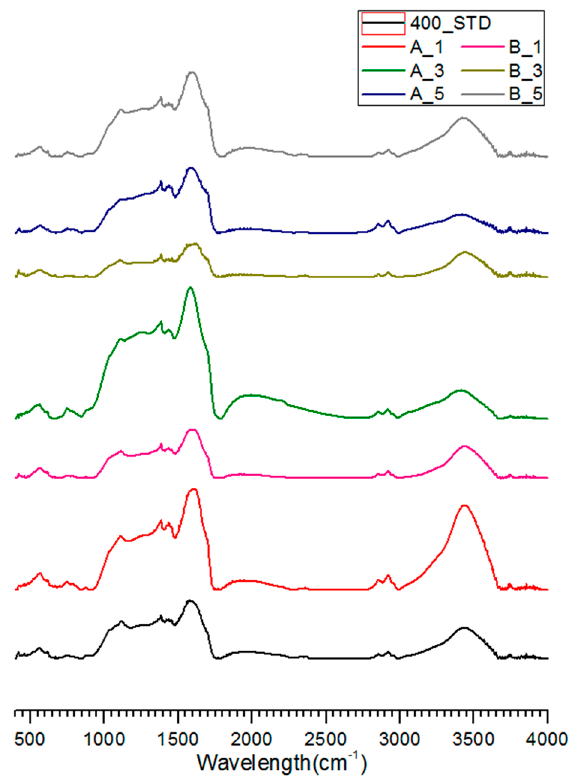
Figure 6. The FT-IR result of biochar pyrolyzed at 300 °C before and after flushing.